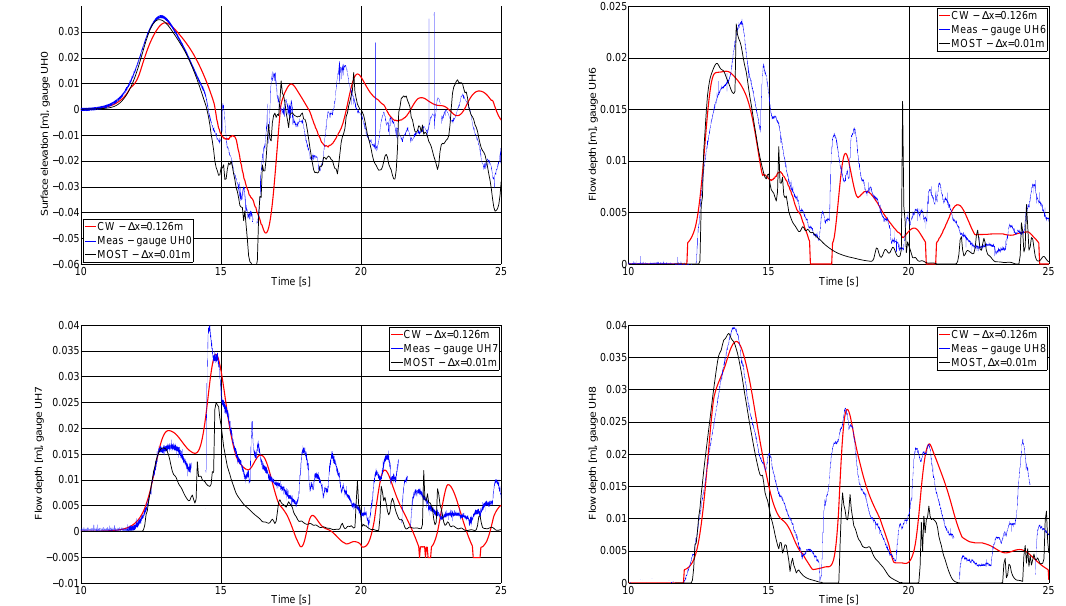
Figure 11. Simulated near-shore wave surface elevation and overland flow depth in Hellesylt for Coulwave and MOST.